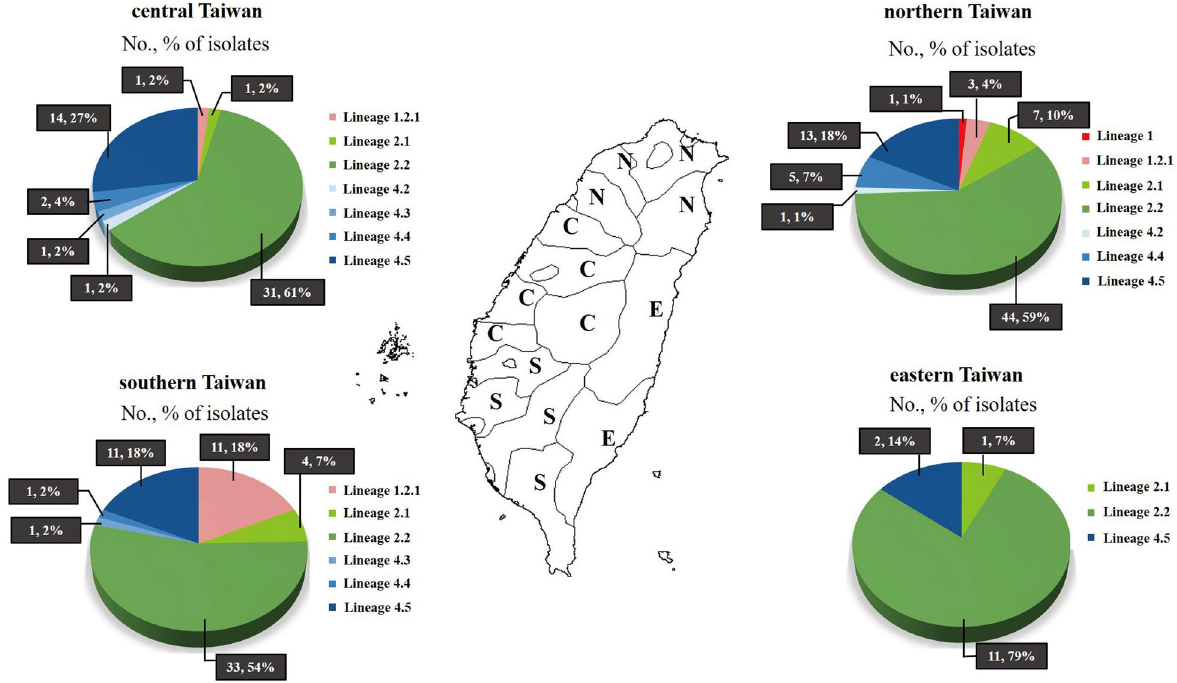
Figure 1. Geographic distribution of lineages and sublineages of drug-resistant M. tuberculosis isolates in Taiwan. The distribution of each phenotype in each district is represented in the corresponding pie chart as indicated. Abbreviations: N, northern Taiwan; E, eastern Taiwan; C, central Taiwan; S, southern Taiwan.